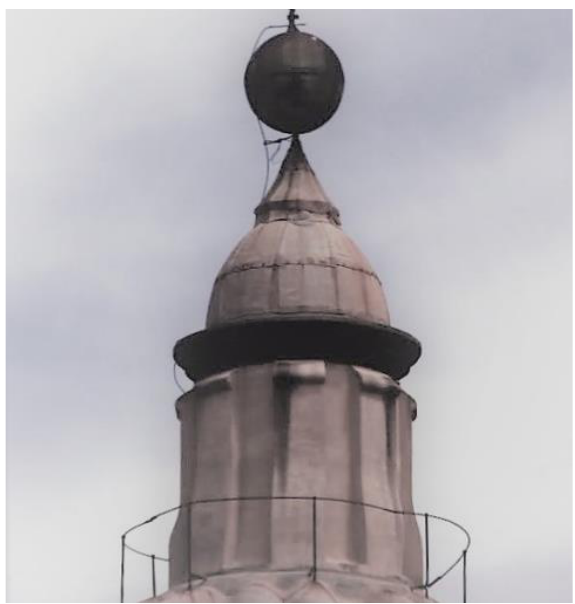
Figure 14. Santa Caterina a Formiello Church. The brick lantern rebuilt after the earthquake of